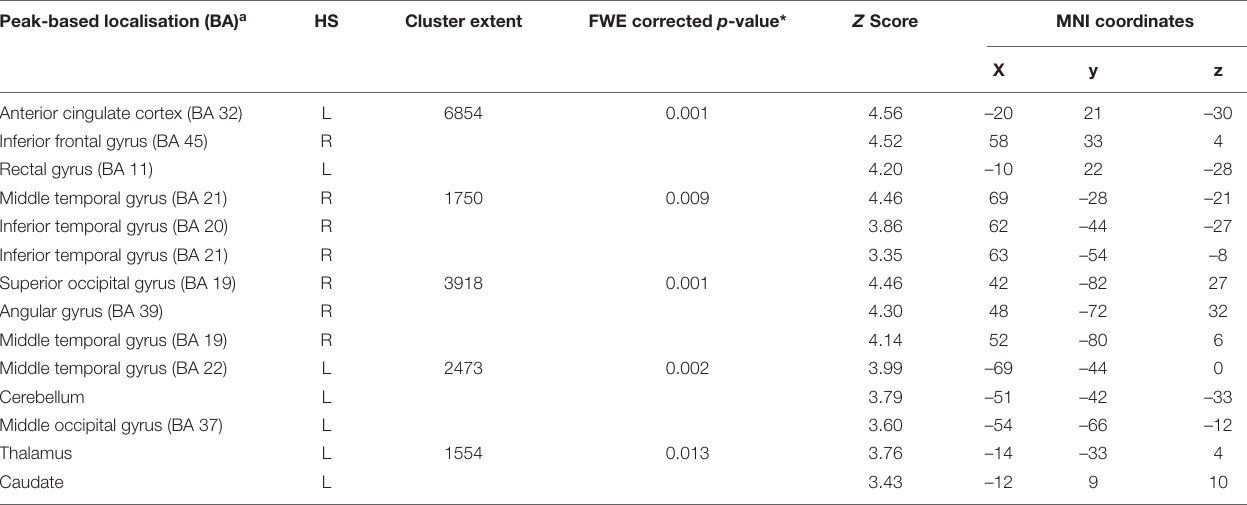
TABLE 4 | Grey matter clusters of significant correlation for the